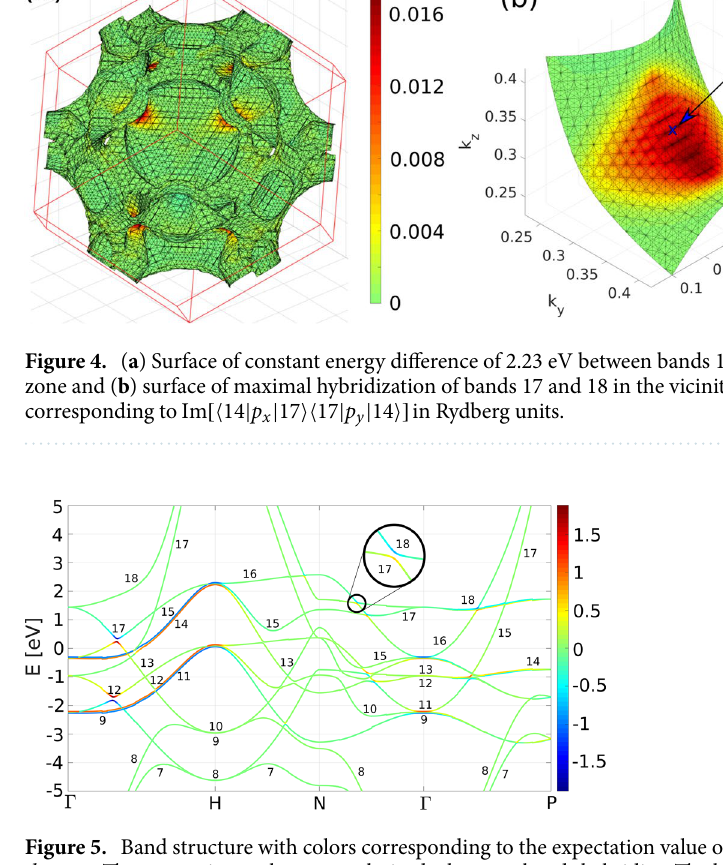
Figure 5. Band structure with colors corresponding to the expectation value of the magnetic number of the d -states. The magnetic number gets polarized whenever bands hybridize. The hybridization of bands 17 and 18 at C (cid:31) is zoomed